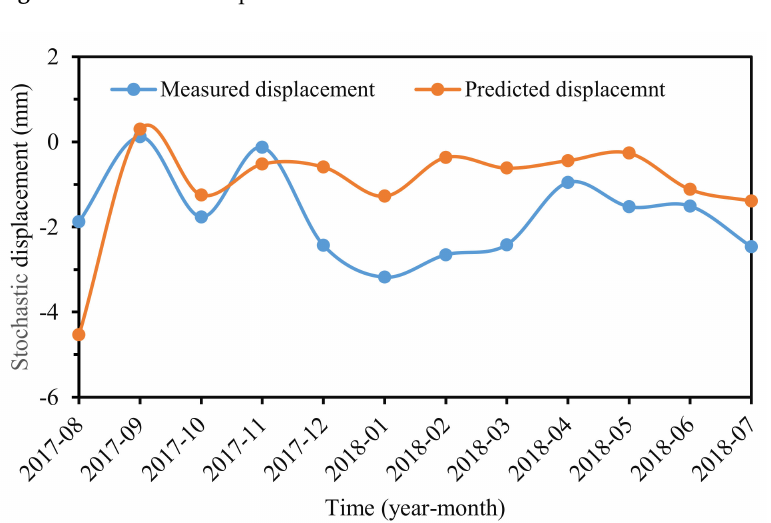
Figure 16. Stochastic displacement at ZG324.